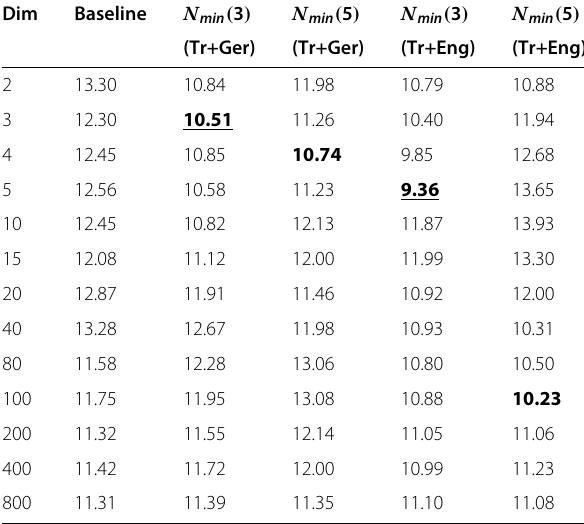
Table 3 Regression performance of the baseline MRMR and ml-MRMR methods for the Turkish task when the minimum occurrence threshold ( N min ) is sets 3 and 5. In the underlined bold case, improvement is significant compared to the baseline system. The result with Gemaps feature set was 11.48